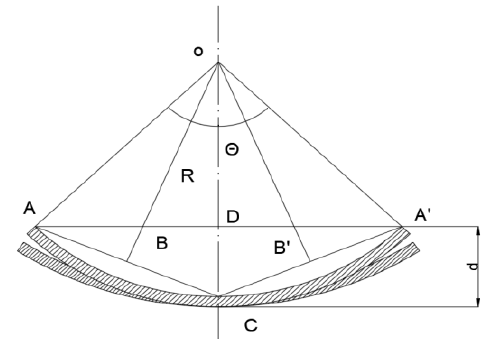
Figure 2. Simplified diagram of springback.